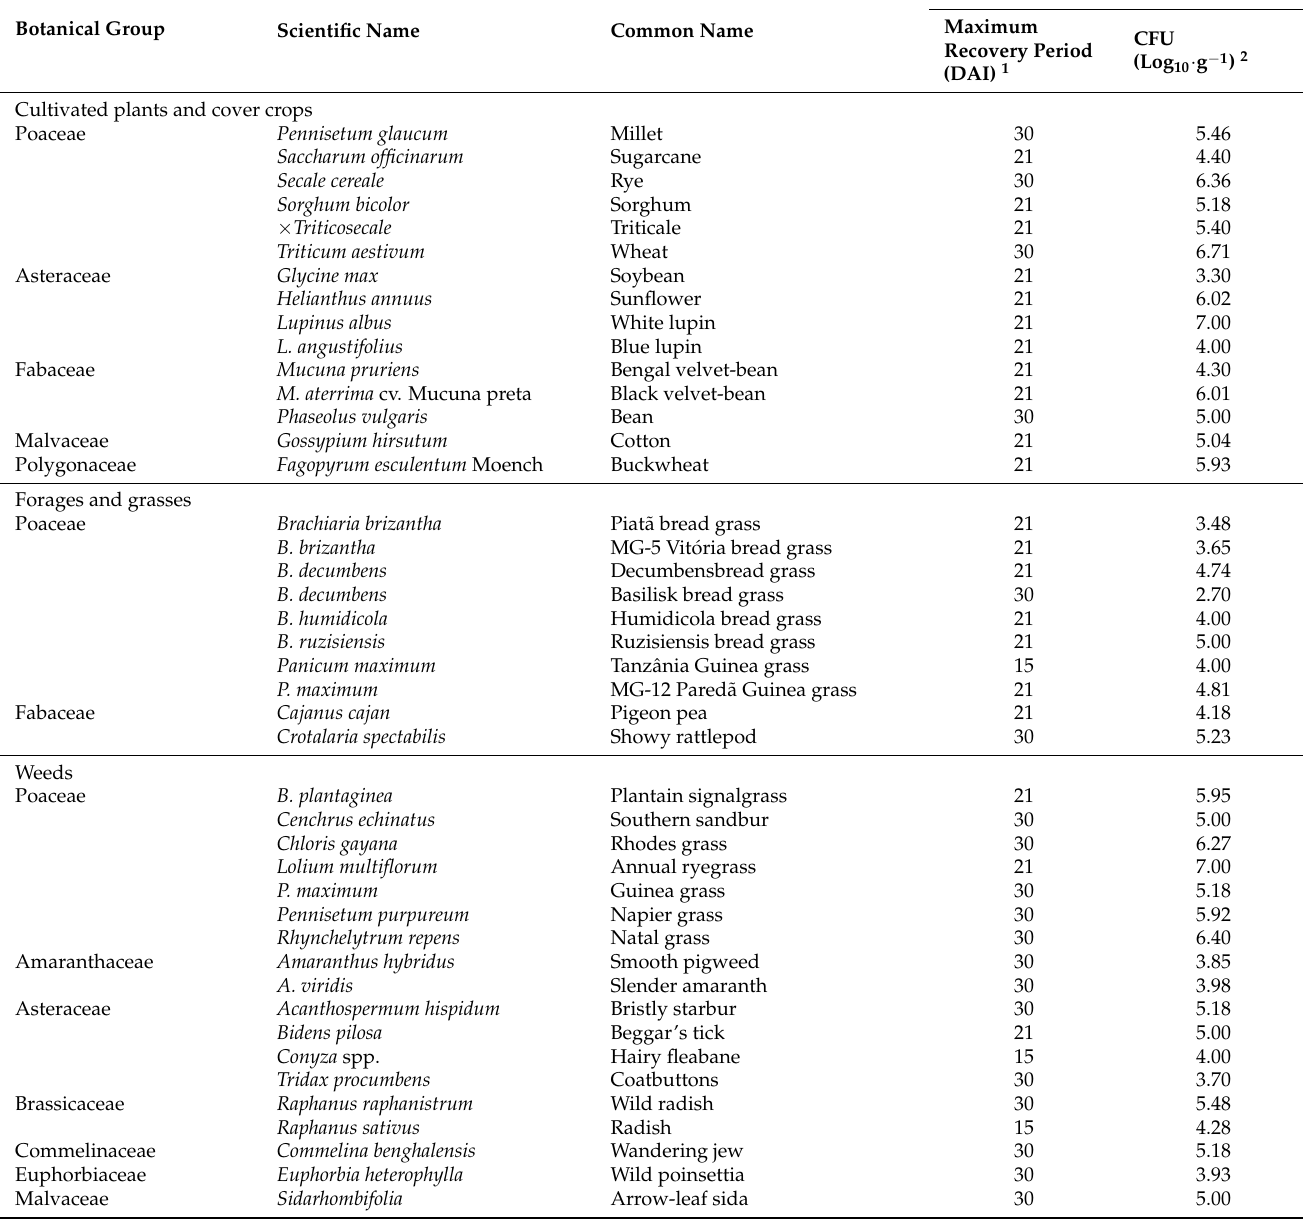
Table 4. Maximum recovery period in days after inoculation (DAI) and colony-forming units (Log 10 CFU · g − 1 ) of Xanthomonas vasicola pv. vasculorum ( Xvv ), the causal agent of bacterial leaf streak (BLS) of maize, in cultivated plants, cover crops, forage, grasses and